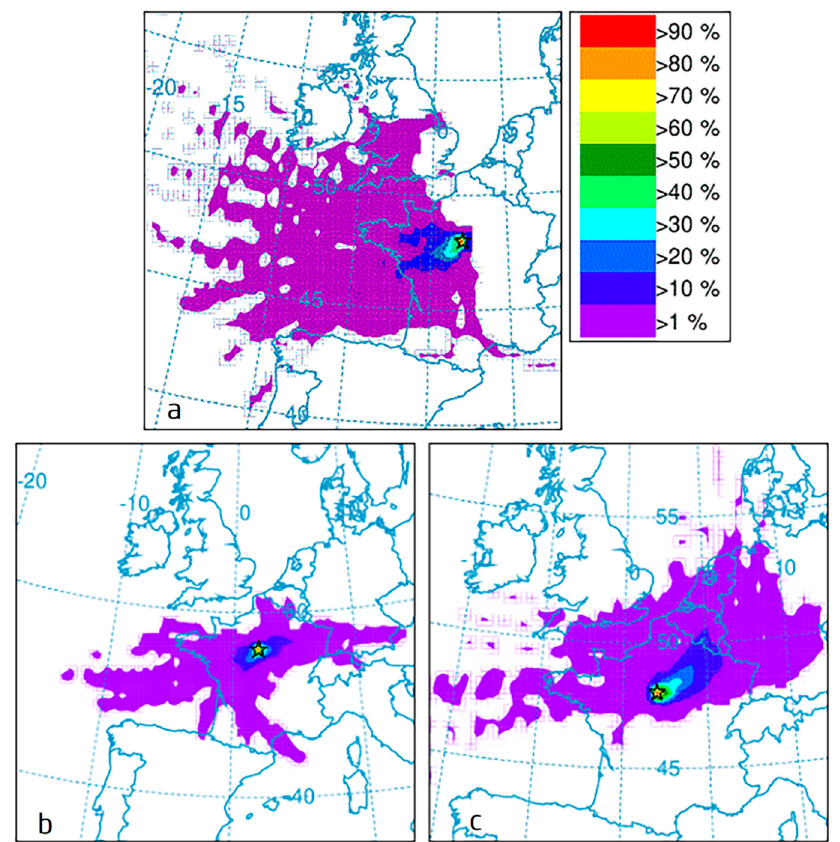
Figure 9. Results of HYSPLIT 24 h back trajectory frequencies before ( a ), during ( b ), and after ( c ) the lockdown. The star represents the location of the measurement site. Height: 500 m above the ground level; frequency grid resolution: 0.5 × 0.5°.